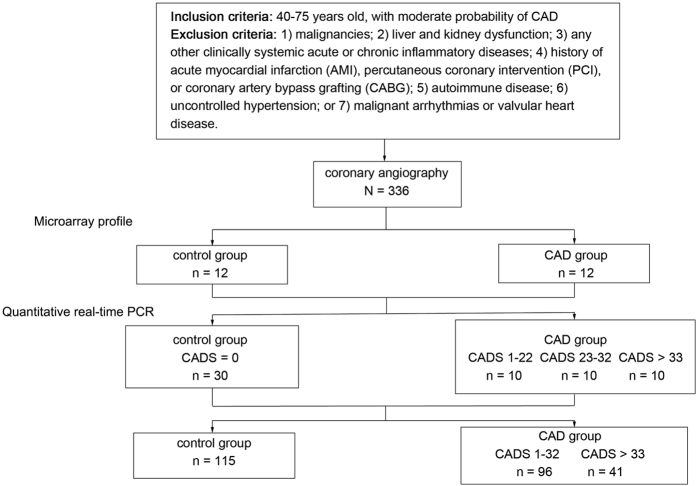
Study flow chart.